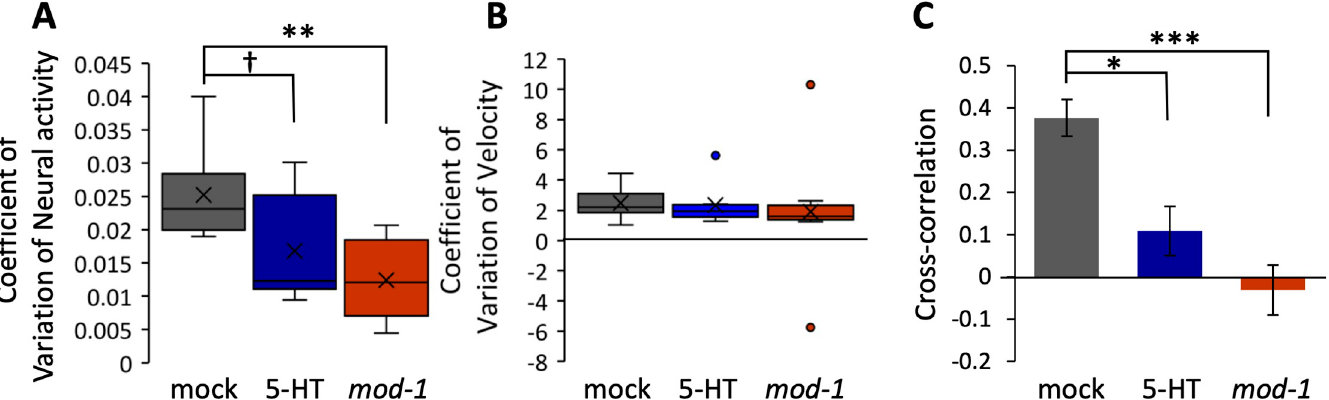
Fig 2. The coefficient of variation of the neural activity, unlike that of velocity, was decreased in animals pre-exposed to 5-HT and mod-1 mutants. (A) The coefficient of variation of the neural activity in the mock, 5-HT pre-exposed, and mod-1 groups. 5-HT: p = 0.074, mod-1 : p = 2.5 × 10 − 3 . (B) Coefficient of variation of the velocity. 5-HT: p = 0.21, mod-1 : p = 0.14. The box plots show the average (cross), median (center line), quartiles (boxes), and range (whiskers). Data were analyzed using the nonparametric test. (C) The cross-correlation of RID neural activity and velocity when the worms moved forward. 5-HT: p = 6.3 × 10 − 3 , mod-1 : p = 6.4 × 10 − 5 . The box plots show the average (cross), median (center line), quartiles (boxes), and range (whiskers), and were analyzed using Dunnett’s test. †p < 0.1, � p < 0.05, �� p < 0.01, and ��� p < 0.001, significantly different compared with mock animals. Mock: n = 9, 5-HT pre-exposed: n = 8, mod-1 : n =